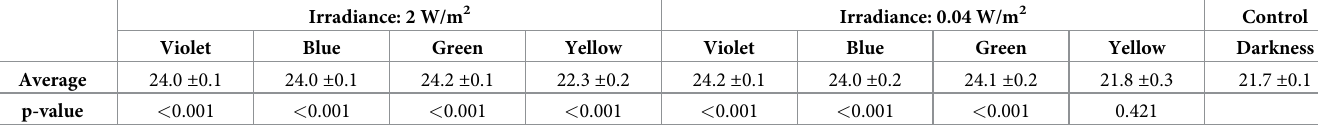
Table 2. The circadian rhythm (hours ± SEM) and the statistical results compared with the control